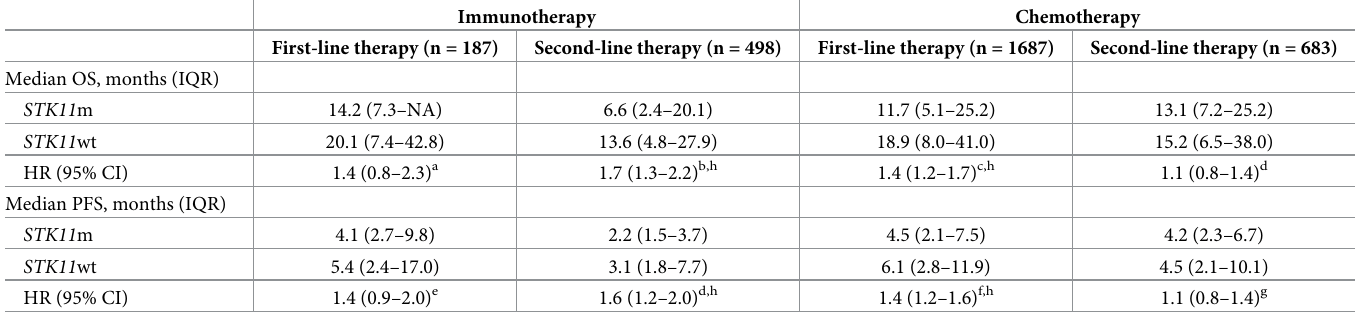
OS and PFS were assessed as time to event from initiation of line of therapy (first-line or second-line). All HR values reported are adjusted HRs calculated using multivariate Cox regression models. Variables in the final adjusted multivariate analysis a Race, stage at initial diagnosis, and ECOG status � 60 days before start of line 1. b ECOG status � 60 days before start of line 2. c Race, gender, smoking history, stage at initial diagnosis, and ECOG status � 60 days before start of line 1.